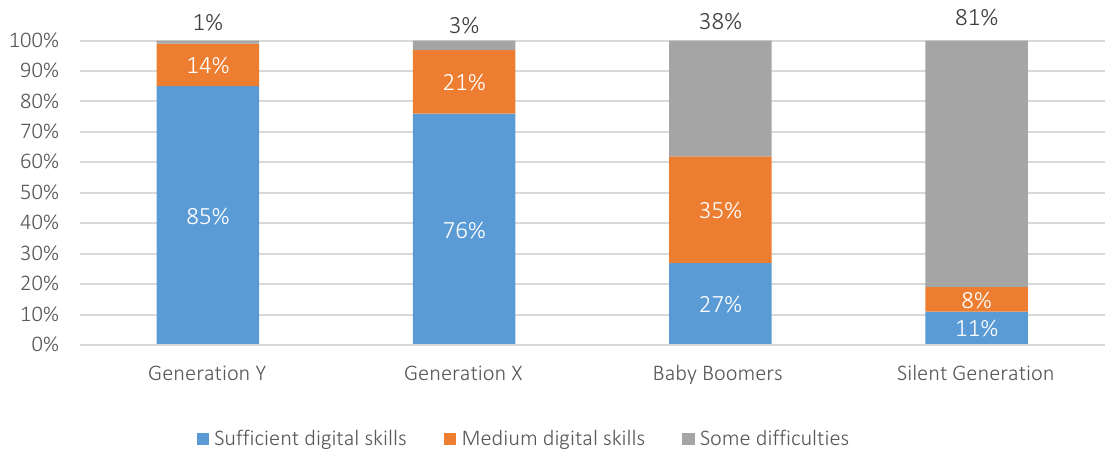
Figure 5. Digital skills of respondents and ability to work